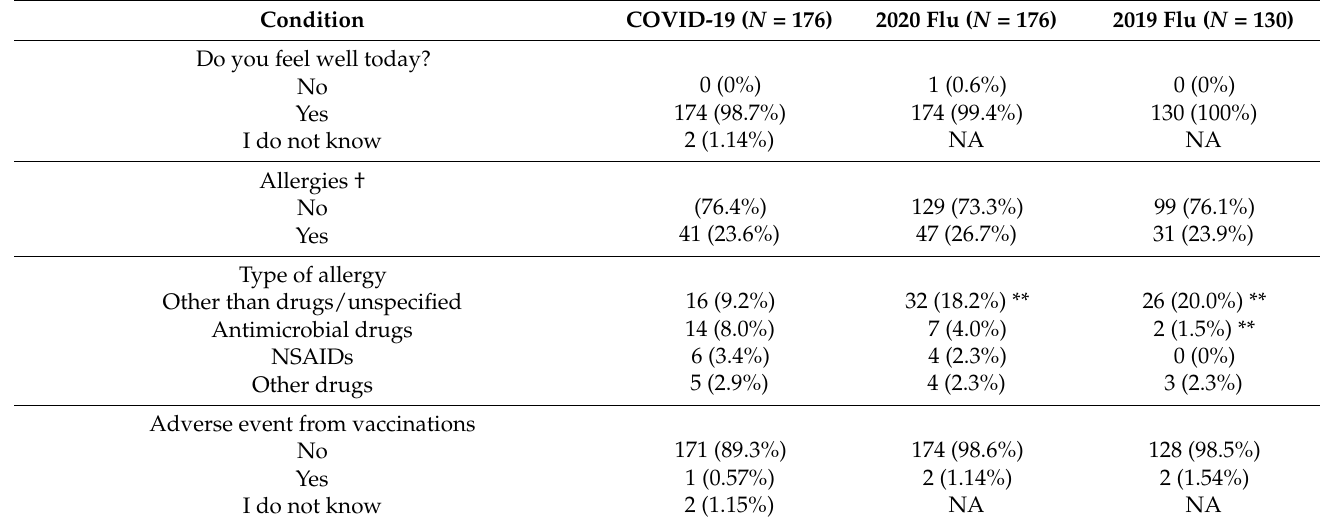
Table 2. Selected conditions reported on